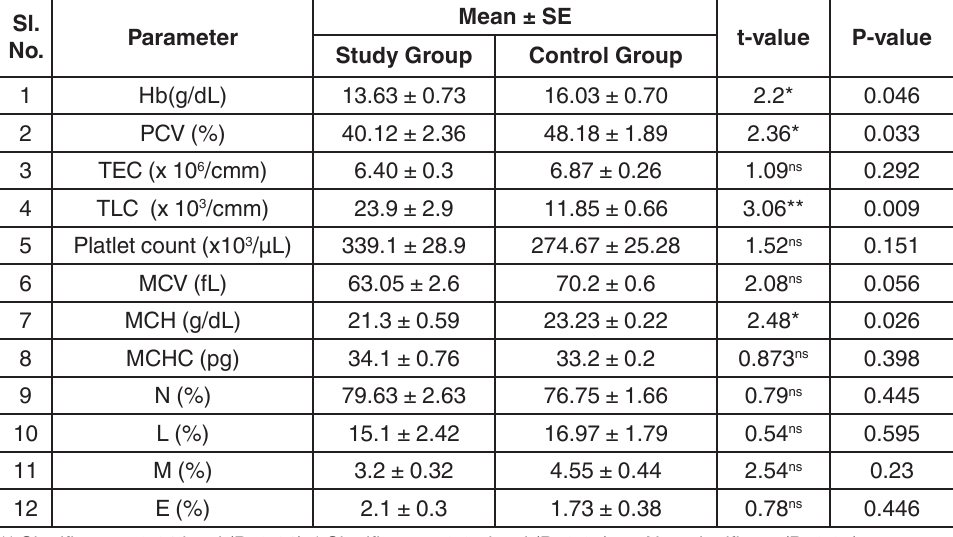
table 1. Comparison of haematology of dogs with malasseziosis and control animals